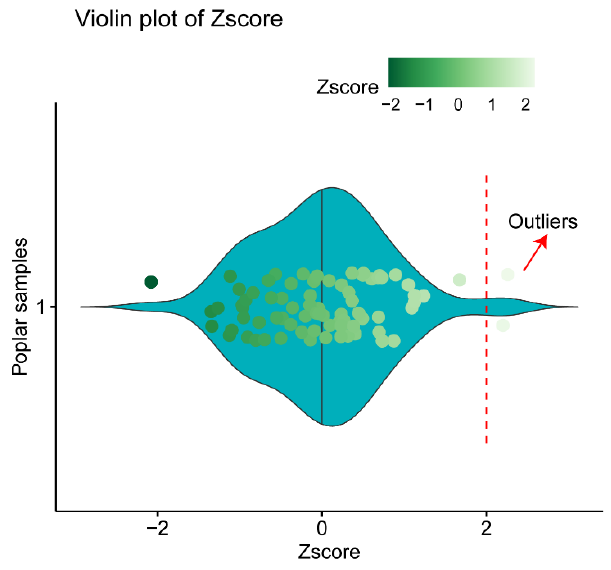
Figure 2. Distribution of Zscore.